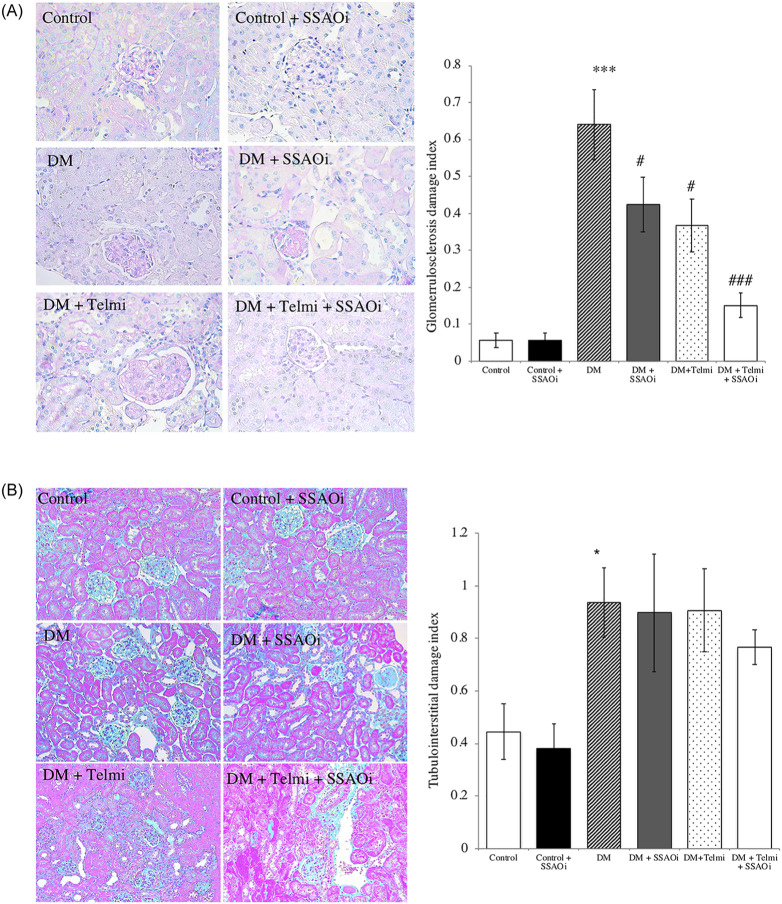
SSAO inhibition reduced glomerulosclerosis but did not reduce the degree of tubulointerstitial fibrosis in diabetic mice.(Fig A) Glomerulosclerosis index representative photomicrographs of PAS stained sections of tubulointerstitium and histograms. (Fig B) Tubulointerstitial damage index: diabetic mice demonstrated tubular atrophy and tubulointerstitial fibrosis, Representative photomicrographs of Masson Trichrome sections and histograms tubulointerstitial damage index. Quantification of tubular atrophy in all groups was done by counting the number of atrophic tubules per 400 tubule count. Data presented as mean ± SEM. (***p<0.001 vs ctrl; #p<0.05, ###p<0.001 vs DM). n = 6–8. Bar = 200μm DM, Diabetes Mellitus; SSAOi, Semicarbazide Sensitive Amine Oxidase Inhibitor; Telmi, telmisartan.